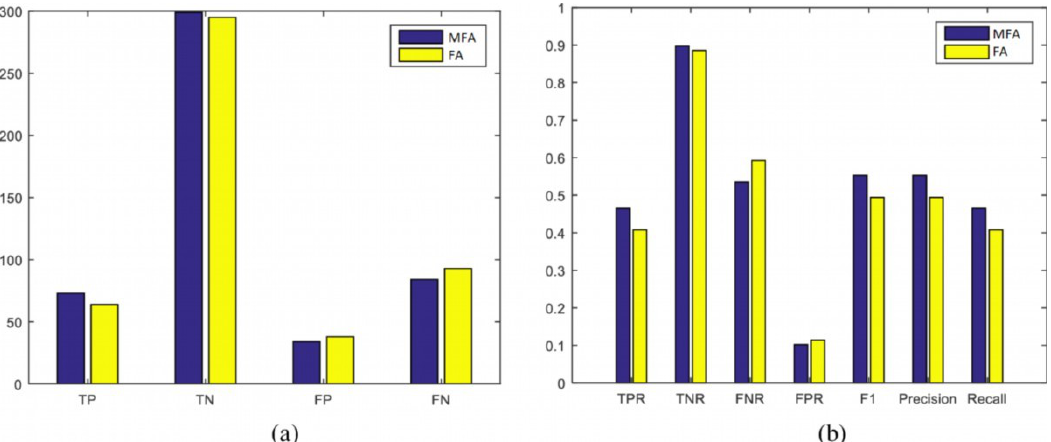
Figure 17. Scenario 2: Statistical evaluation of MFA-OSELM and FA-OSELM using two sets of measures, ( a , b ), for the TampereU dataset.